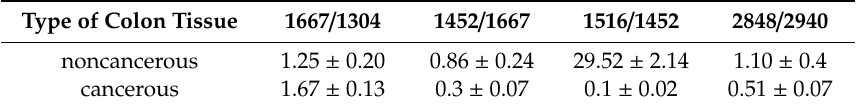
Table 2. The average ratios of lipid and protein constituents for the noncancerous and the cancerous human colon tissue samples for tubular carcinoma of the colon, cancer stage